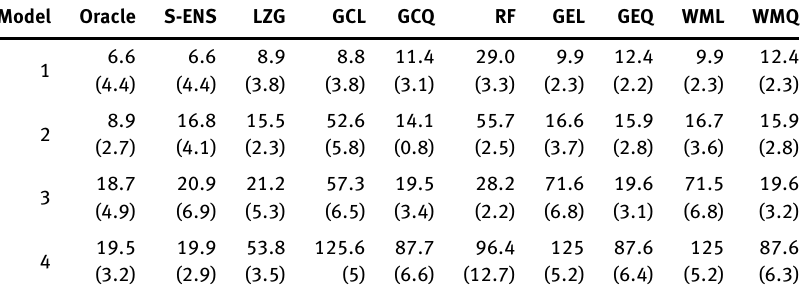
Table 1: Accuracy of regression causal effect estimation. The number in the top (bottom) of each cell is the sample average (standard deviation) of the deviation between the regression causal effect and its estimate over 200 replicates, multiplied by 100. “Oracle” stands for the oracle estimator, “S-ENS” for the proposed method based on the sparse ensemble moment- based estimator, “LZG”, “GCL”, “GCQ” and “RF” for the semiparametric, the linear, the quadratic, and the random forest G- computations, “GEL”,“GEQ”, “WML”, and “WMQ” for G-estimation and Wallace and Moodie’s approach with the regression causal effect fitted by linear model and quadratic model,